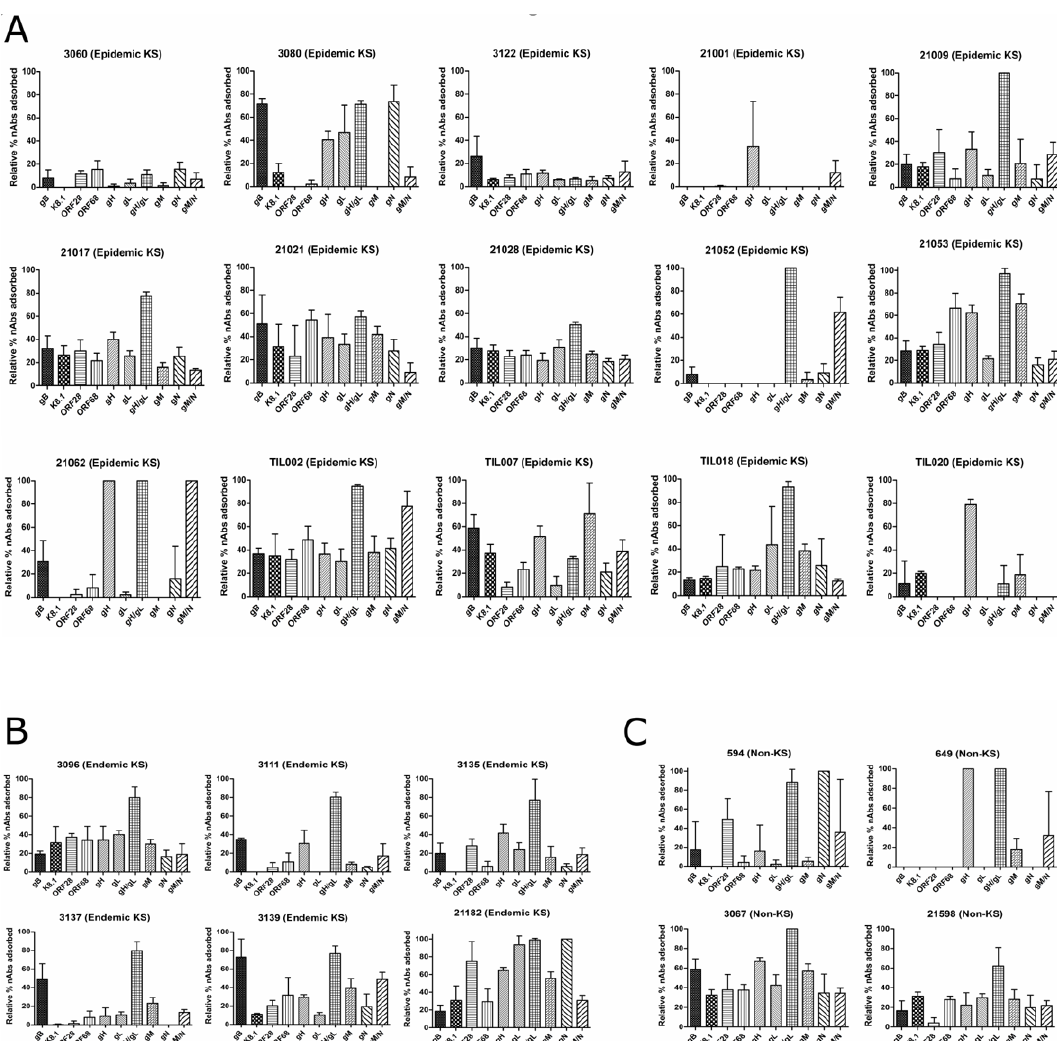
Figure 3. Antigenic determinant of KSHV-specific neutralizing antibodies (nAbs) in the plasma of KSHV-infected individuals. Heat-inactivated plasma of the study participants was absorbed with KSHV glycoproteins-expressing 293T cells, and neutralization assays were carried out as described in material and methods. The relative percentage of nAbs absorbed is shown for ( A ) epidemic KS (EpKS) cases, ( B ) endemic KS (EnKS) cases and ( C ) non-KS (asymptomatic KSHV-infected ) cases.